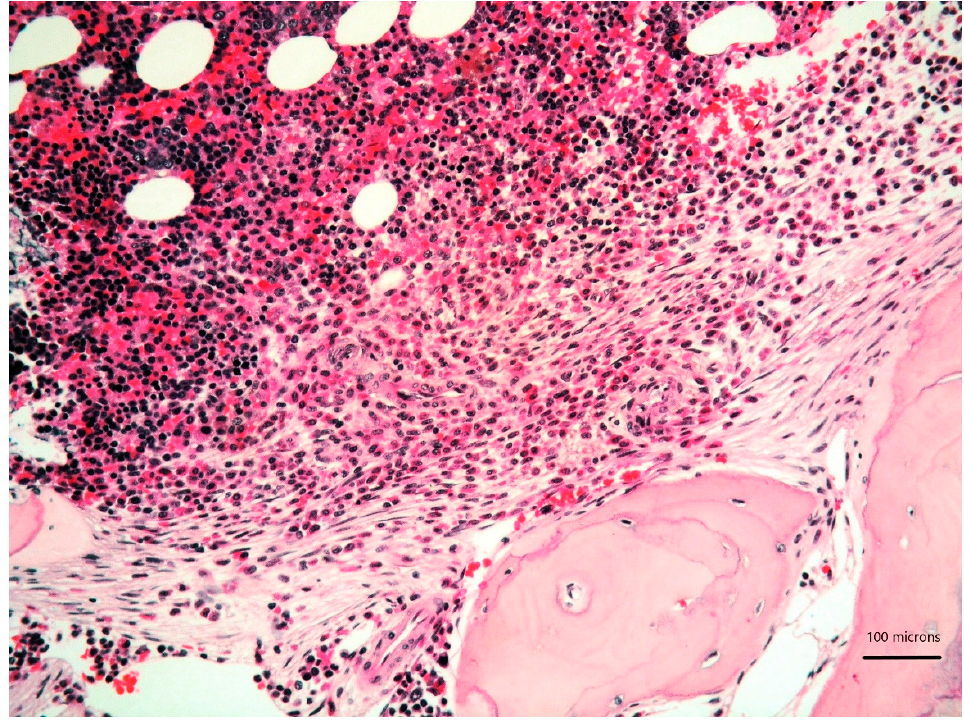
Figure 1. Bone marrow biopsy showing paratrabecular aggregates of spindle-shaped cells ( lower part ) close to clusters of mature plasma cells ( upper part ) (haematoxylin and eosin, 200× magnification).